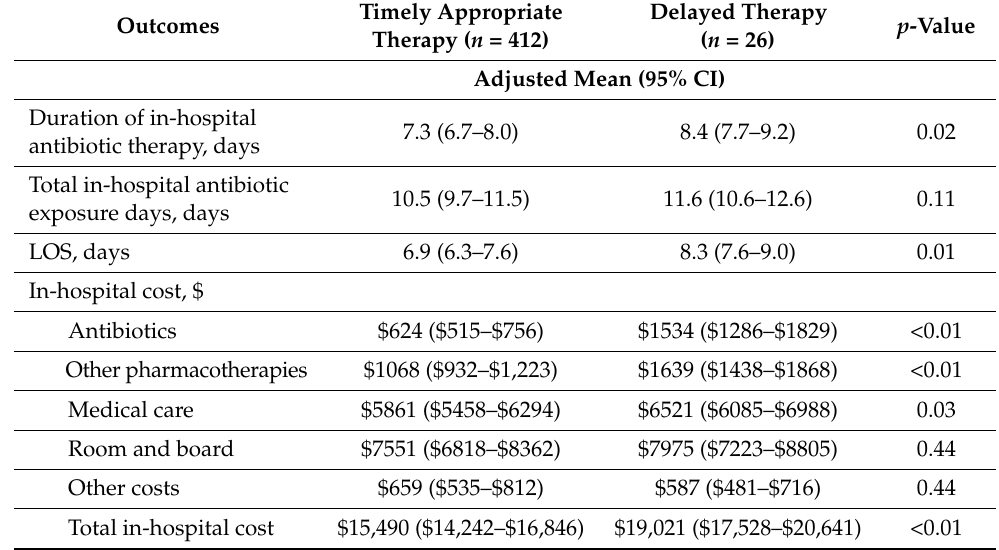
Table 4. Multivariable-adjusted utilization and cost